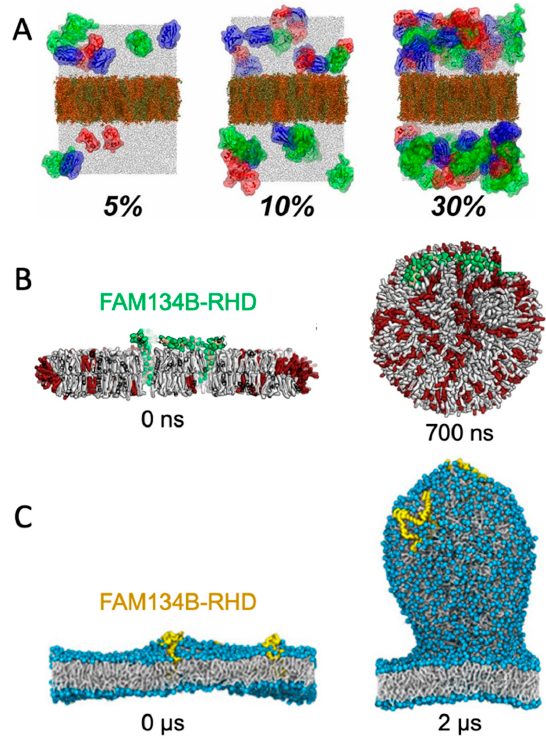
Figure 2. Simulating membrane curvature induction. ( A ) Bending of plane periodic bilayer by protein crowding. Figure adapted with permission from Ref. [24] (copyright 2019, PNAS license). ( B )